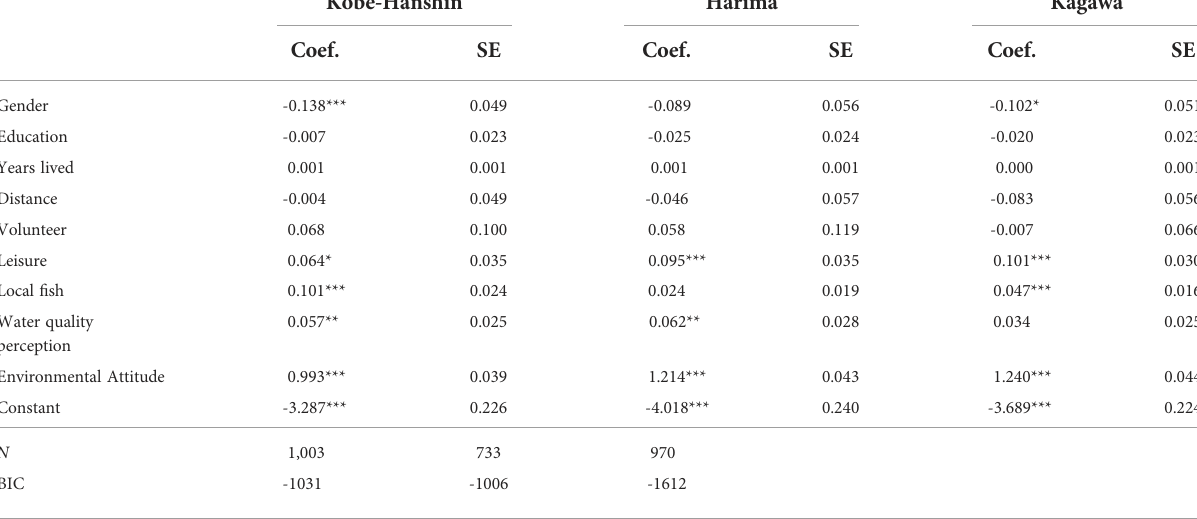
TABLE 6 Estimates of beta regression to explain relational values by